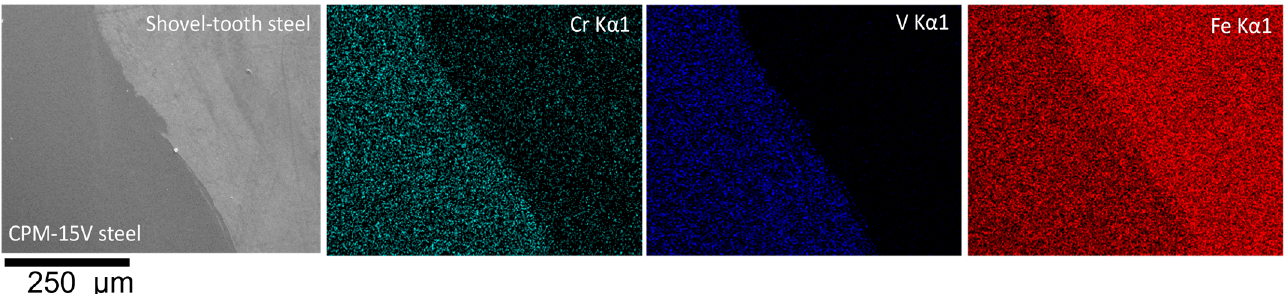
Figure 10. Intermixing of microstructures in some limited regions observed by SEM at the interface for the HF condition, where ( b ) is an enlarged micrograph of ( a ).